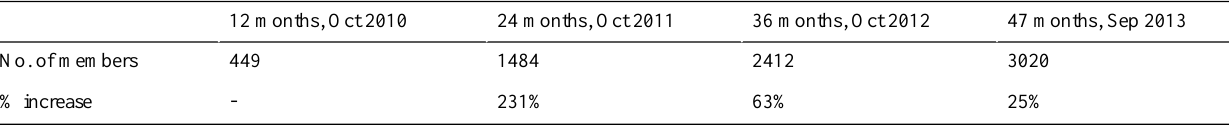
Table 1. InspireNet membership growth.